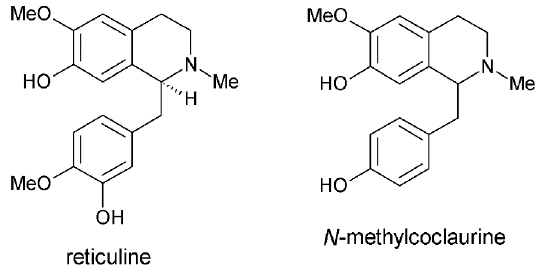
Figure 1. Reticuline and N -methylcoclaurine